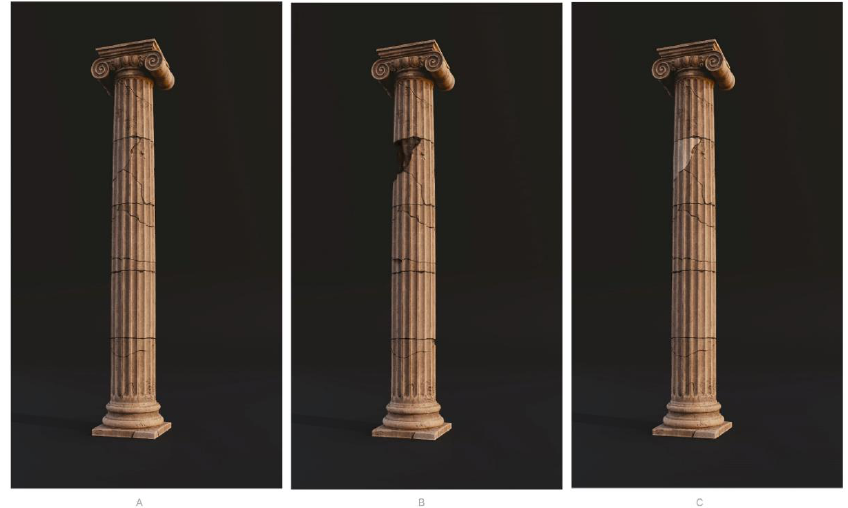
Figure 1. Three types of anastylosis used in the experiment: ( A ) complete; ( B ) with an empty cavity; ( C ) with a cavity filled with lighter stone.